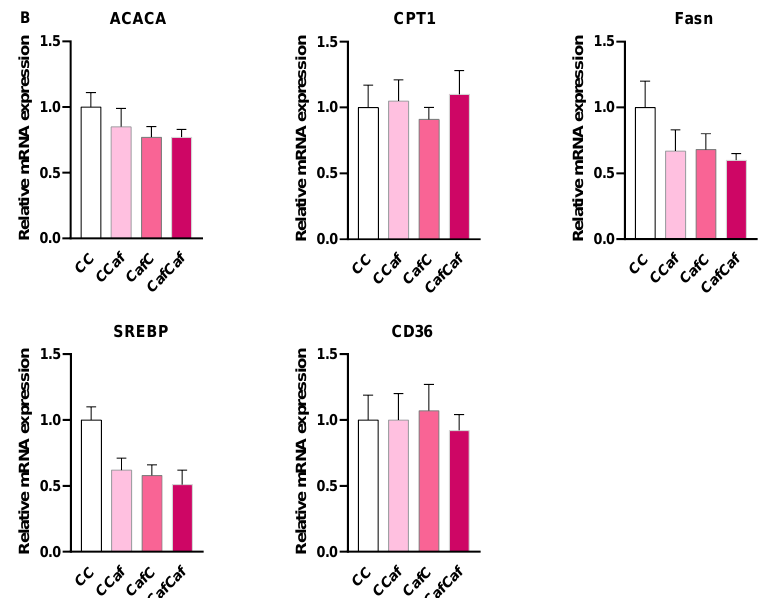
Figure 12. Liver ACACA, CPT1, Fasn, SREBP, and CD36 mRNA expression in males ( A ) and females ( B ) at 14 weeks of age. ChowChow (11 male, 11 female), ChowCaf (11 male, 11 female), CafChow (13 male, 11 female), and CafCaf (13 male, 13 female); C depicts chow. Data are expressed as mean ± SEM and were analysed by two-way ANOVA. * p < 0.05 main effect of the maternal Caf